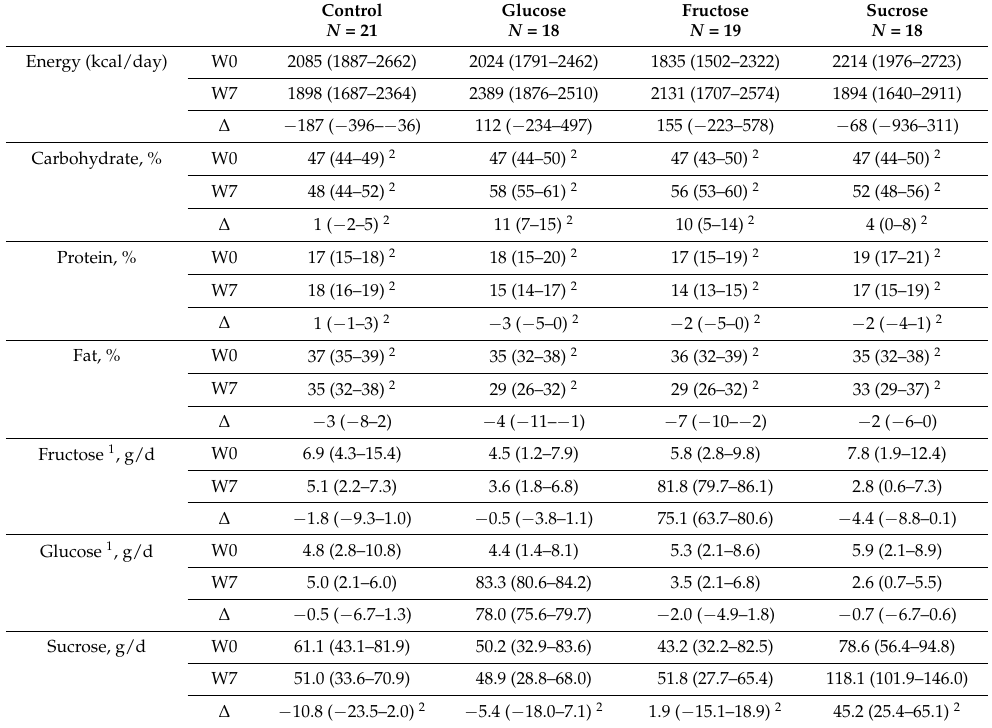
Table 3. Dietary intake of the subjects of the different groups at baseline (W0) and after intervention